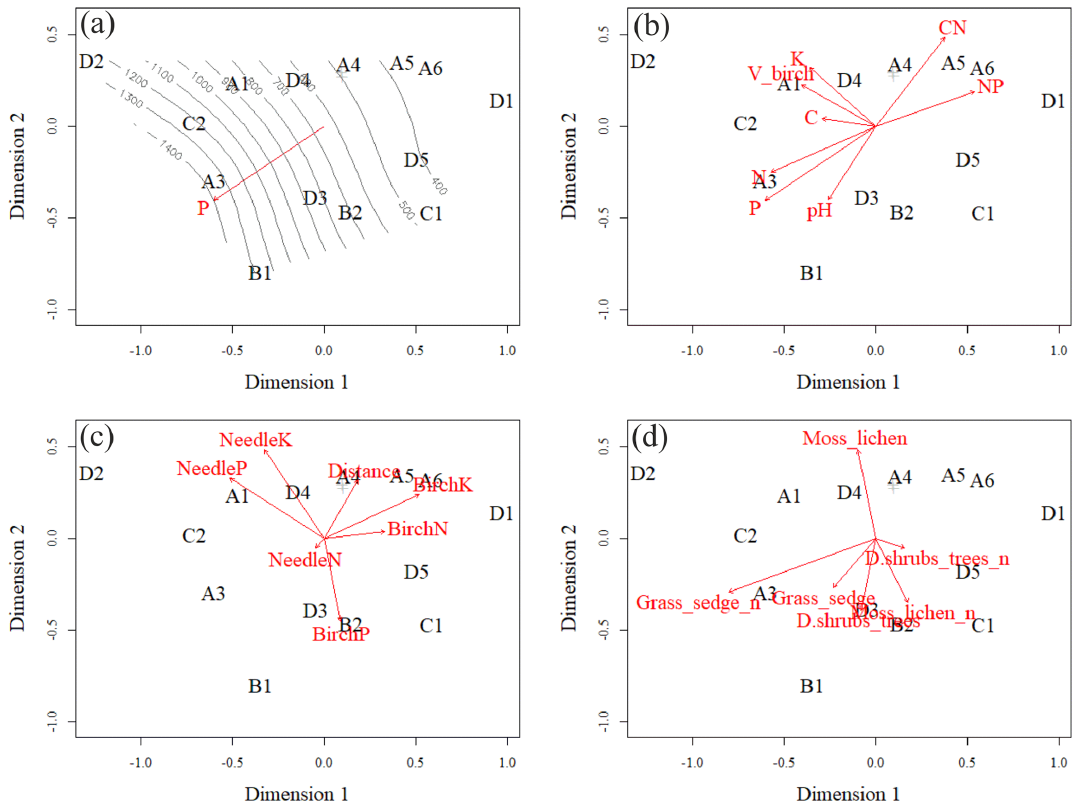
Figure 7. Ordination pattern with smooth surface fit and linear vector fit of soil phosphorus (P) in the O layer (a) , linear vector fits of soil element contents in the O layer (b) , linear vector fits of foliar data and plot distance from Sokli phosphate ore (c) , and linear vector fits of number of species in different layers of understorey (d) . Moss_lichen includes moss and lichen species; Grass_sedge includes forb, grass, and sedge species; and D.shrubs_trees includes dwarf shrubs and tree seedlings. Plots A4, B3 and A2 were located on top of each other, and only A4 is